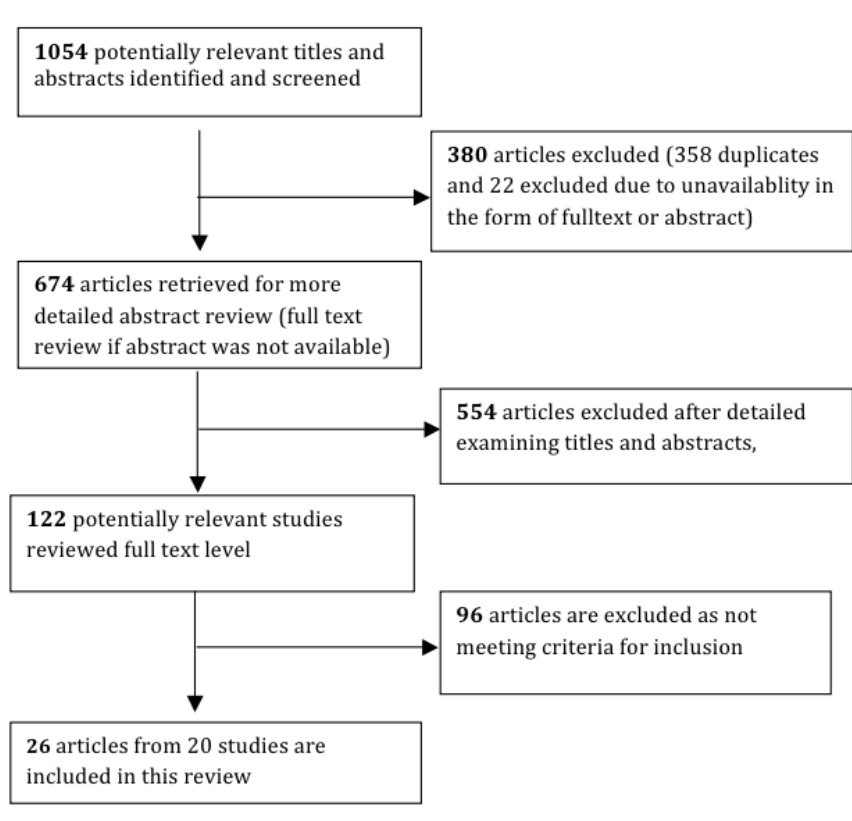
Figure 2. Flow chart of search